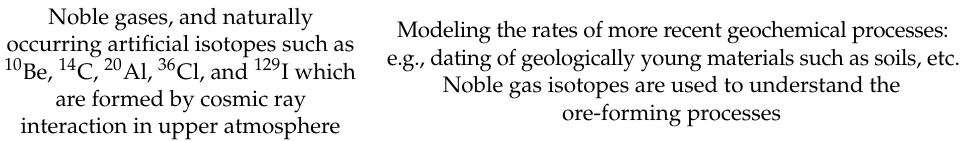
redox conditions (Mn, Fe,